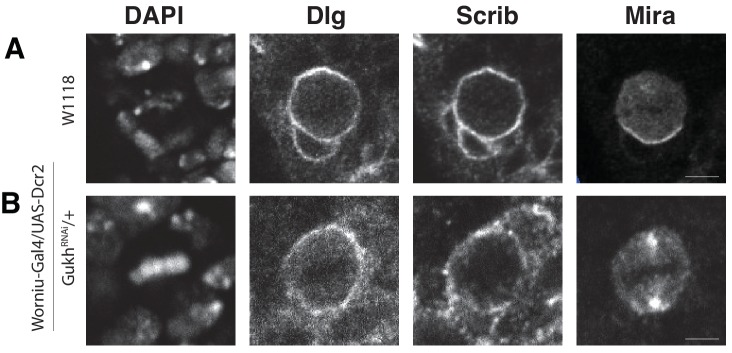
GukHolder is not required for localization of its binding partner, the polarity protein and tumor suppressor Scribble.Neuroblasts were stained with DAPI (DNA), anti-Dlg, anti-Scrib, and anti-Mira antibodies (A) Worniu-Gal4 > WT (no RNAi) (B) Worniu-Gal4 > GukH RNAi.